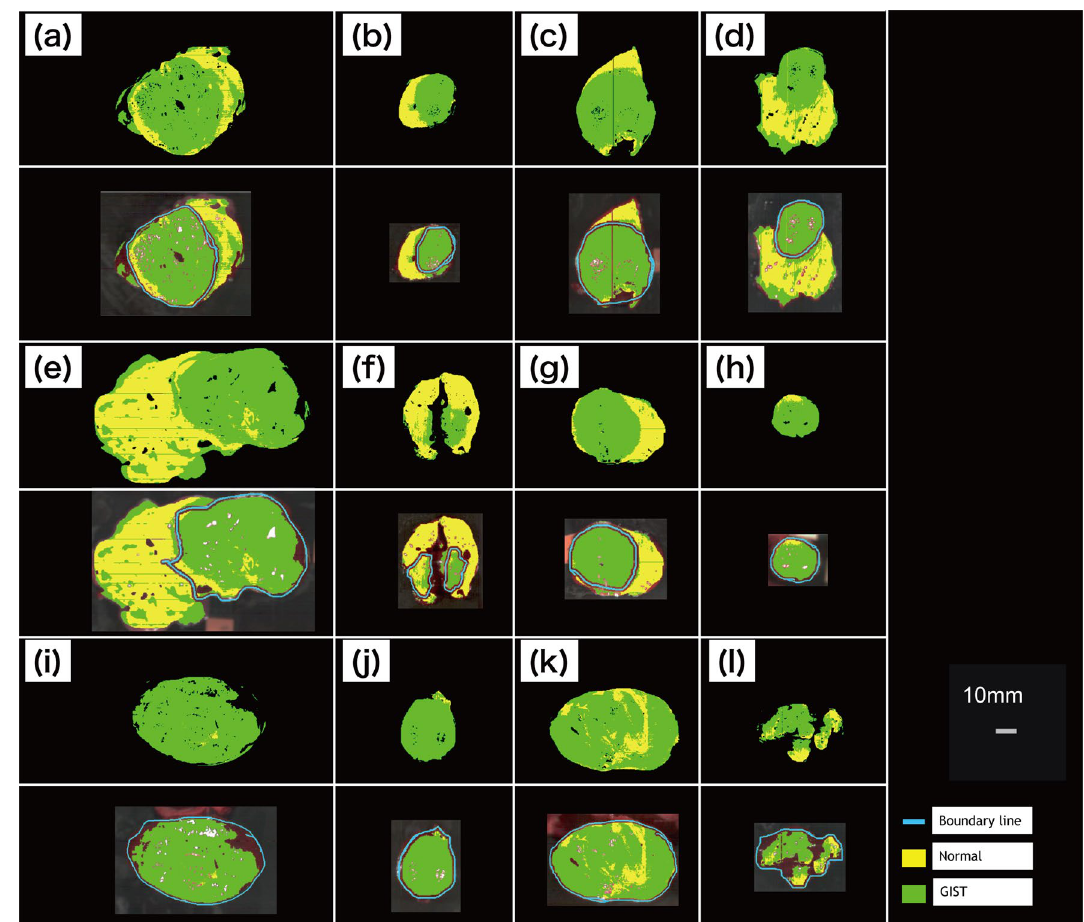
Figure 3. GIST region prediction analyzed by machine learning. (( a – l ) upper images) The whole specimen. (( a – l ) lower images) Merging of color-coded pixels and NIR picture with boundary line drawn by pathologist. The color-coded pixels near the boundary line were excluded. GIST gastrointestinal tumor, NIR near-infrared.